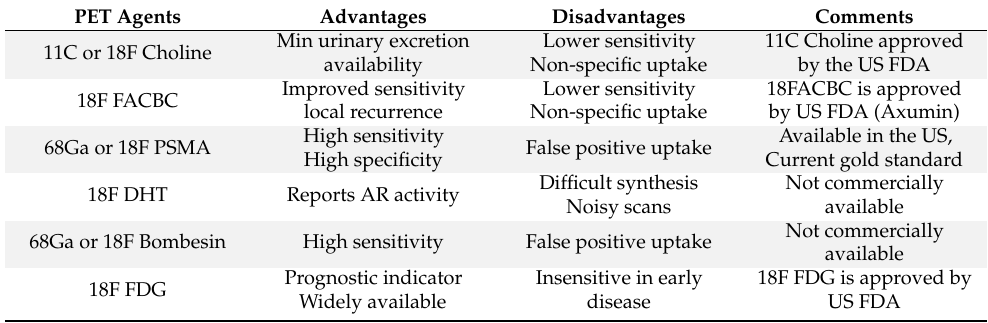
Table 3. Reprinted/adapted with permission from (Peter Choyke), (Novel PET imaging methods for prostate cancer; published by World Journal of Urology, 2021). Copyright 2021, Wolters